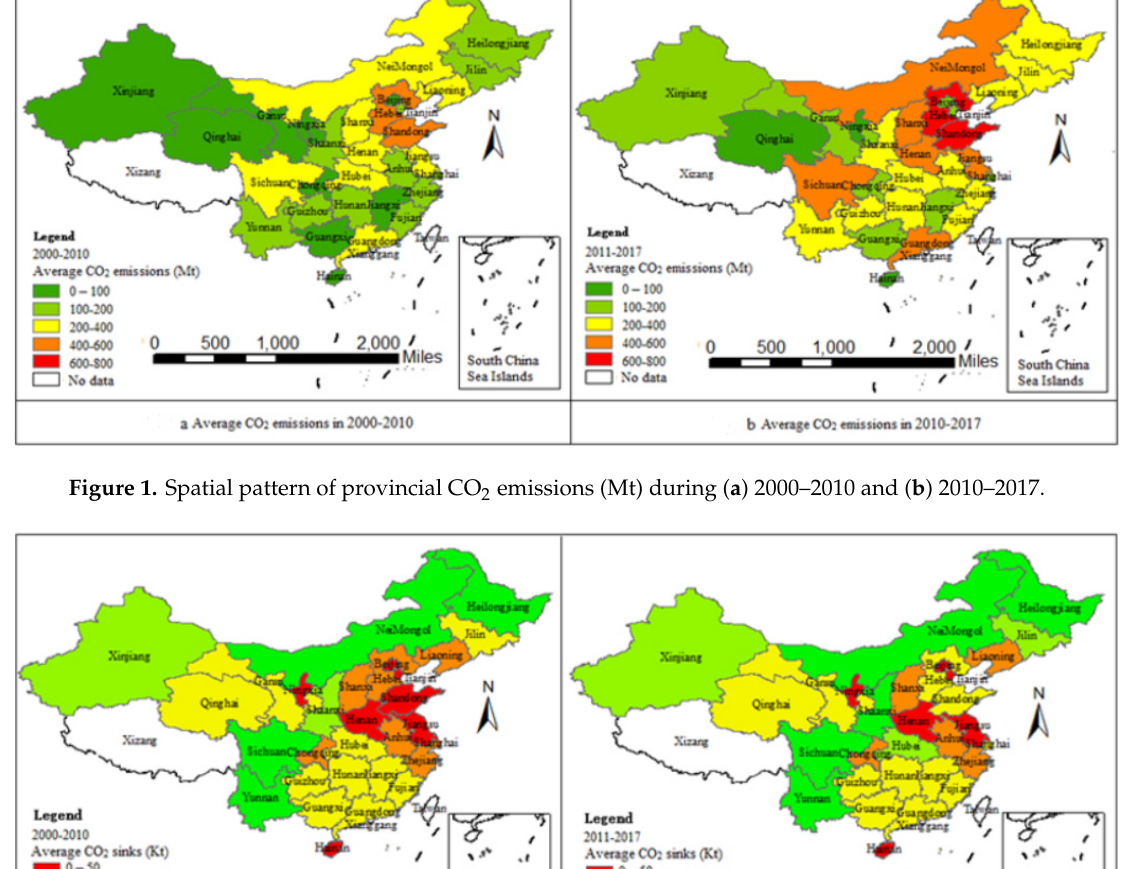
Figure 1. Spatial pattern of provincial CO 2 emissions (Mt) during ( a ) 2000–2010 and ( b ) 2010–2017.